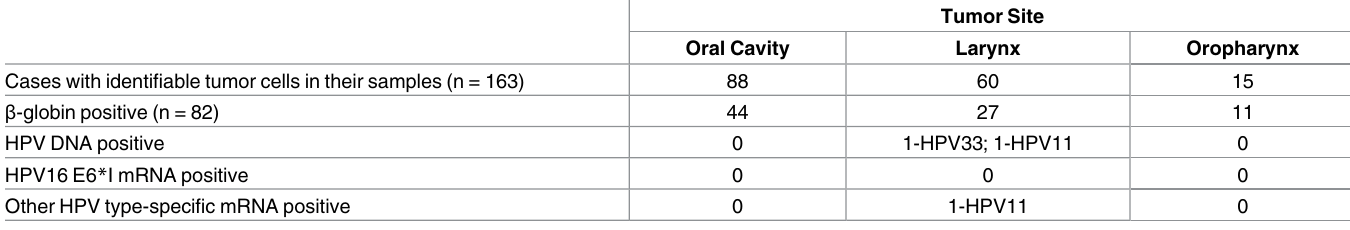
Table 2. Results of molecular